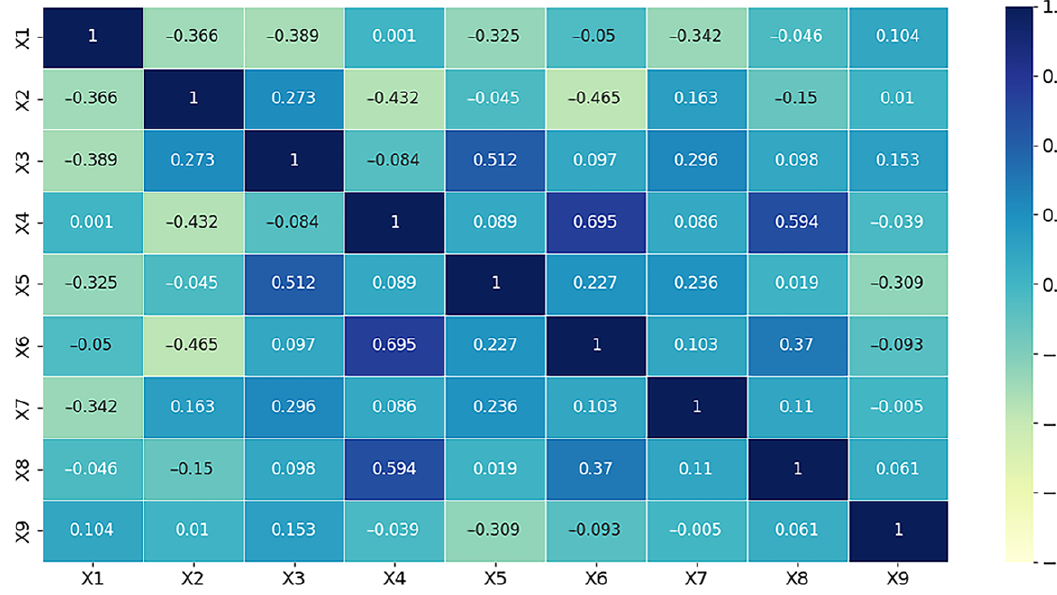
Figure 5. Correlation matrix heat map.